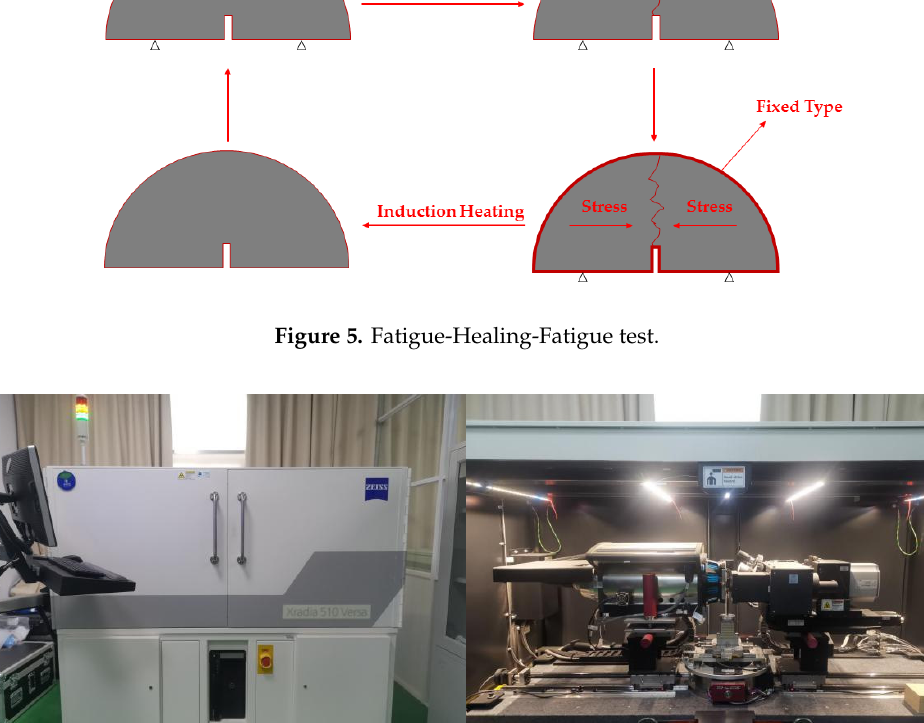
Figure 5 Fatigue-Healing-Fatigue test.